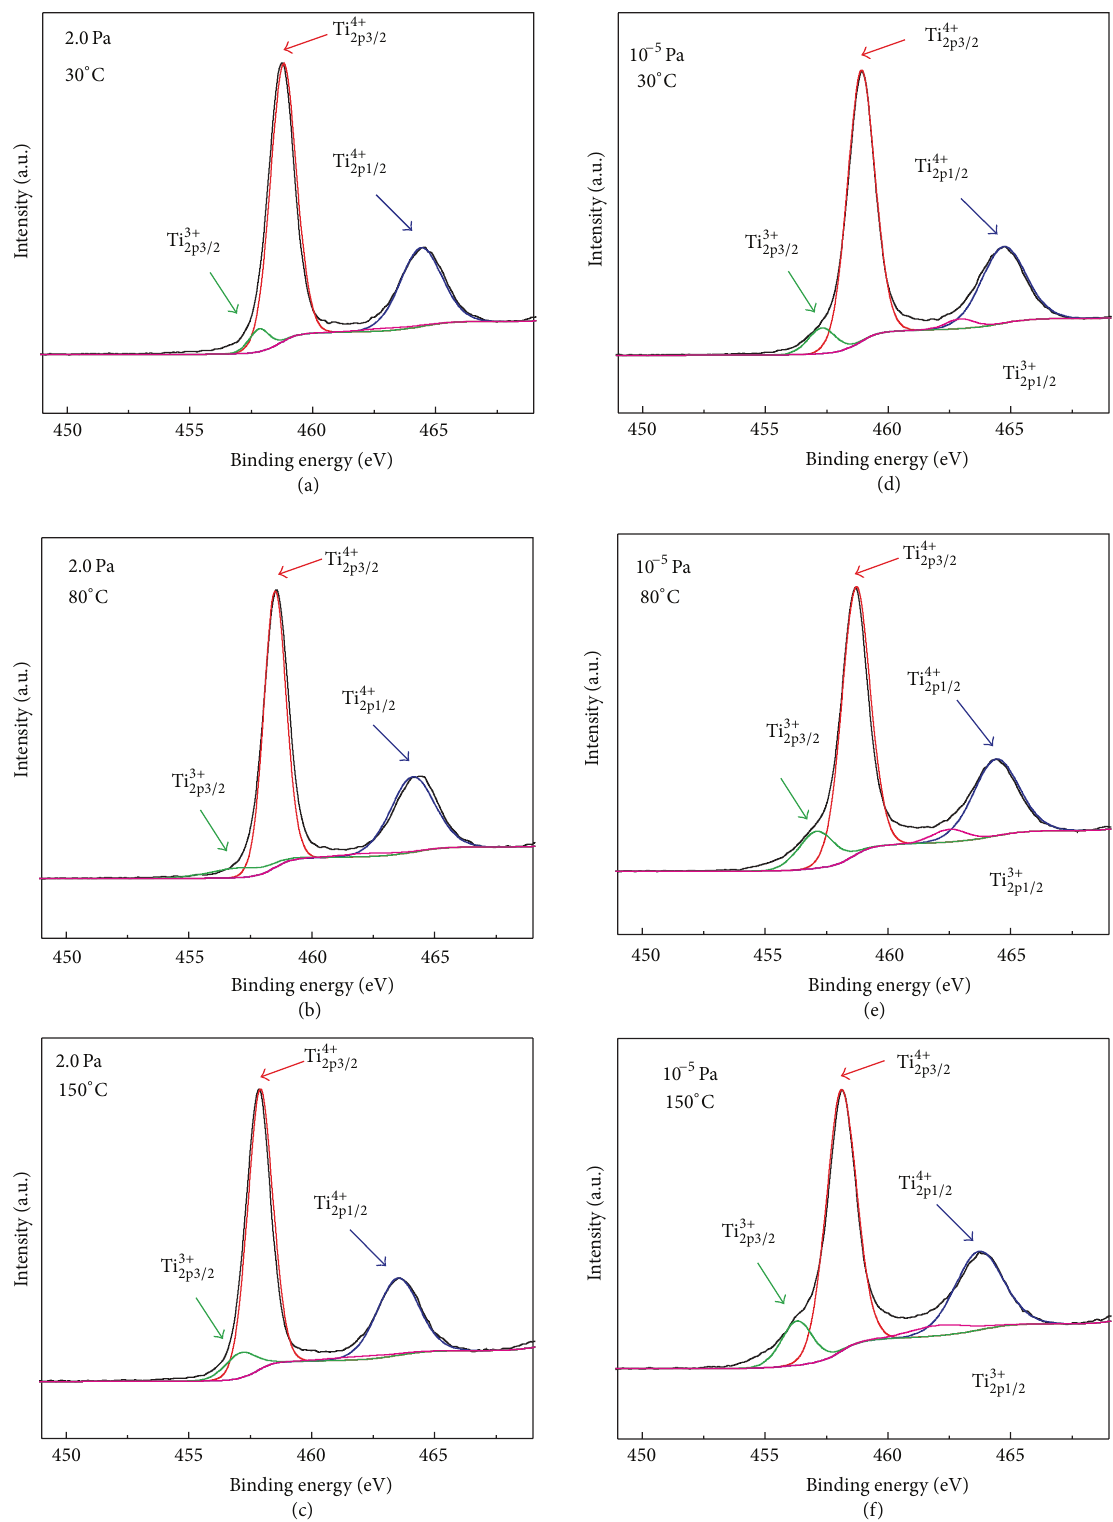
Figure 4: XPS spectra of Ti 2p photoemissions in TiO 𝑥 deposited at 30 (a, d), 80 (b, e), and 150 ∘ C (c, f) in 2.0 Pa oxygen pressure (a–c) and in background vacuum